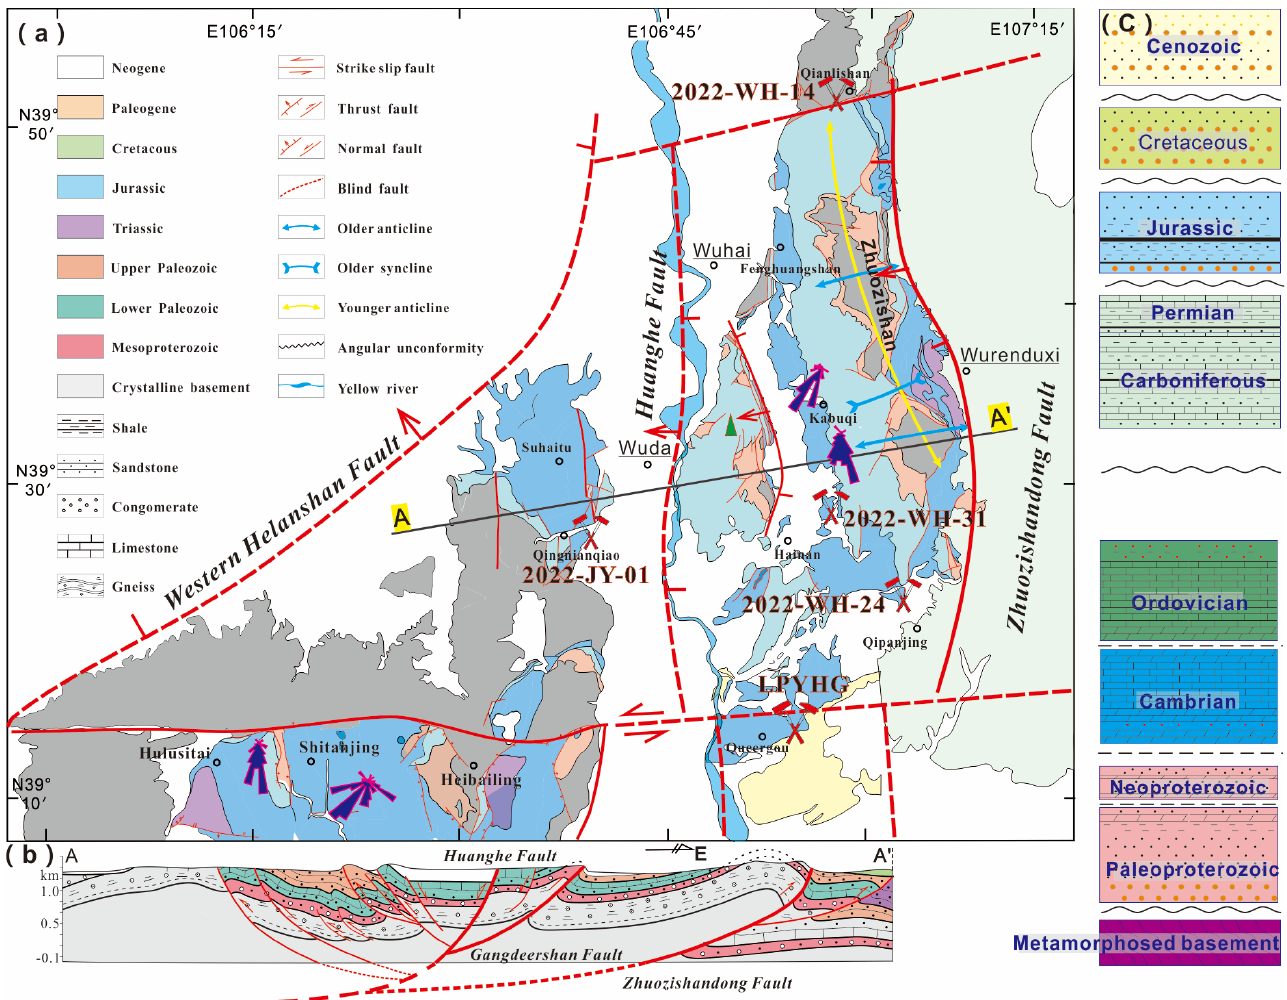
Figure 2. ( a ) Regional–scale map showing major faults and folds as well as stratigraphic units and their spatial distribution of the Wuhai Coalfield, with hammer symbols plotting approximal locations of zircon U − Pb dating samples. Paleocurrent data are from Sun and Dong [2]. ( b ) W − E transection outlining structural architecture of the Wuhai Coalfield (Modified from Yang et al. [20]). ( c ) Schematic column showing the stratigraphic sequence of the Wuhai Coalfield.